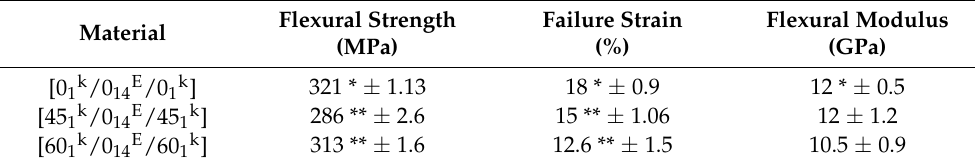
Table 3. Three-point bending properties for E-glass/epoxy and different hybrid composites.